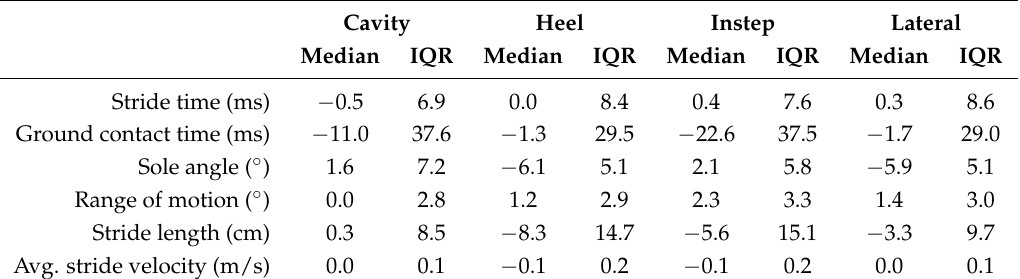
Table 3. Median error and IQR of the error for the parameters stride time, ground contact time, stride length, average stride velocity, sole angle, and range of motion compared to the motion capture system.